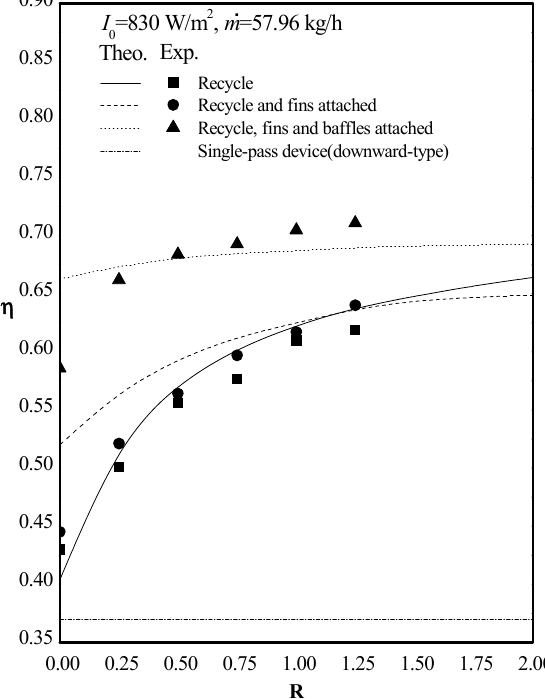
Figure 5. Effect of recycle ratio on collector efficiency in a double-pass flat-plate solar air heater with recycle; I = 830 W/m 2 , m  = 57.96 0